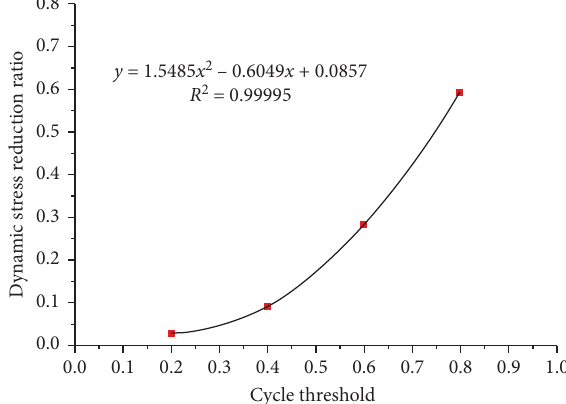
Figure 7: The relationship between dynamic stress reduction ratio and damage degree of sandstone.